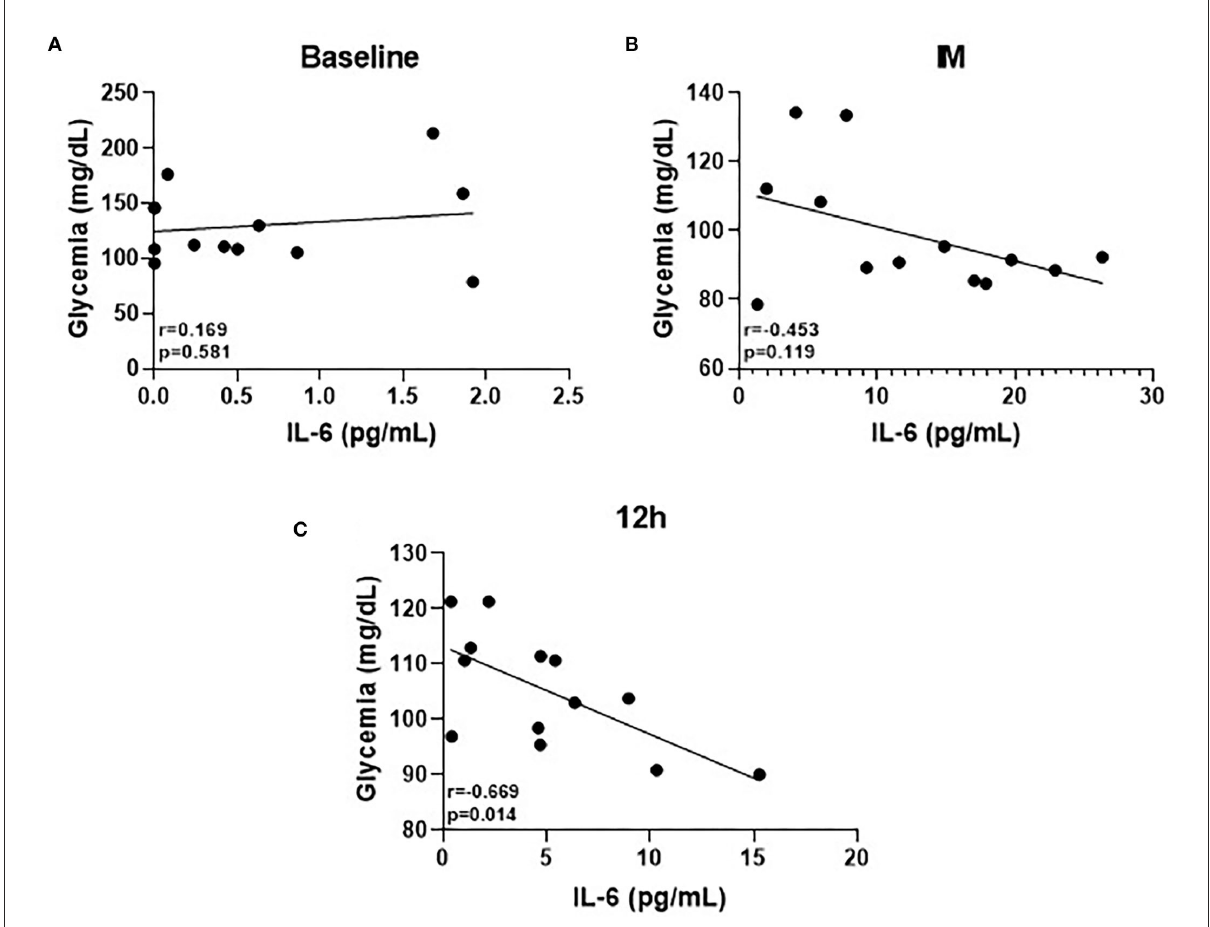
FIGURE4 (A–C) Pearson’s correlation of IL-6 cytokine at the three time-points.